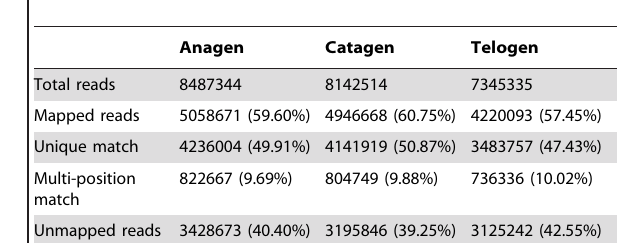
Table 2. Summary of read numbers based on the RNA-Seq data from cashmere goat hair follicle development and